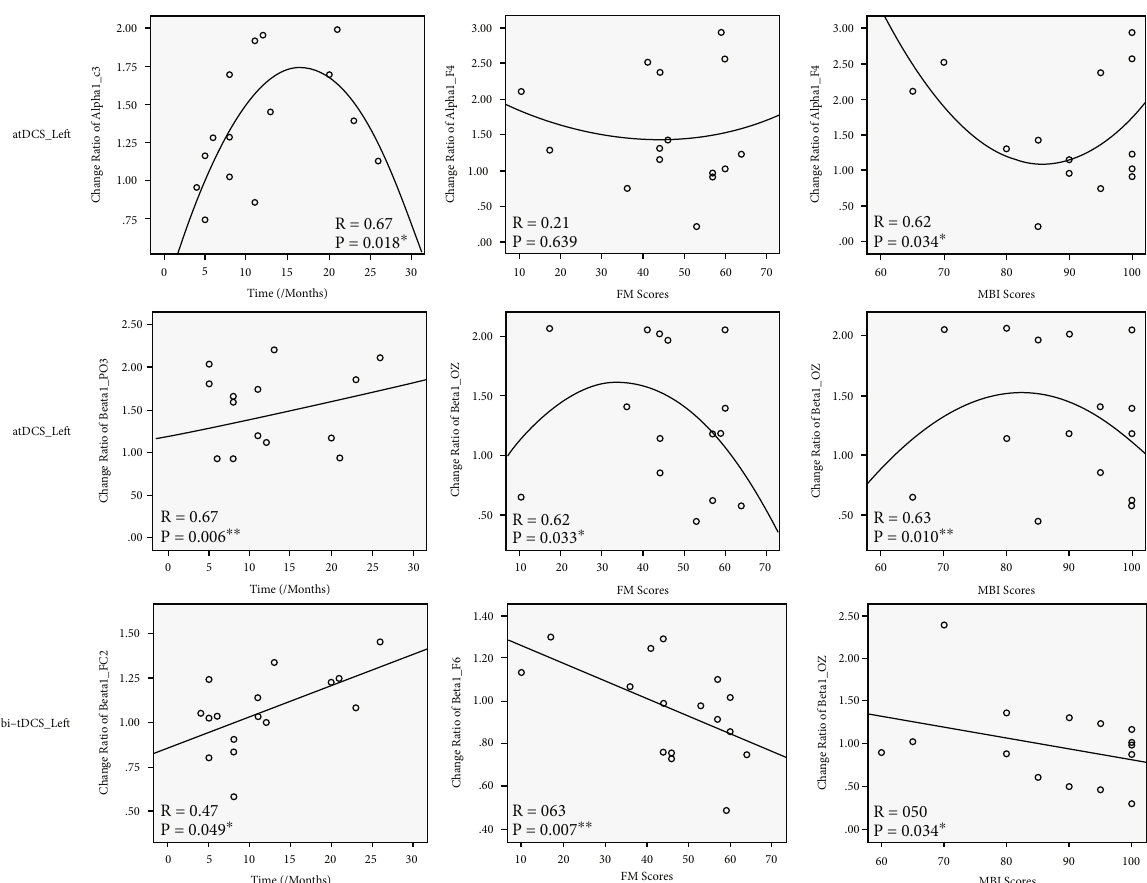
Figure 2: Scatter plots and fi tted curves of clinical characters and the change of spectral power ratio of post- to prestimulation. atDCS_Left represents the group of stroke subjects with the left hemispheric lesion induced by anodal transcranial direct current stimulation (atDCS), and bi-tDCS_Left represents the group of stroke subjects with the left hemispheric lesion induced by bilateral transcranial direct current stimulation (bi-tDCS). Time represents the time poststroke; FM scores represent the Fugl-Meyer scores (upper extremity part); MBI scores represent the modi fi ed Barthel